Question: Looking at the figure, what chart type is it?
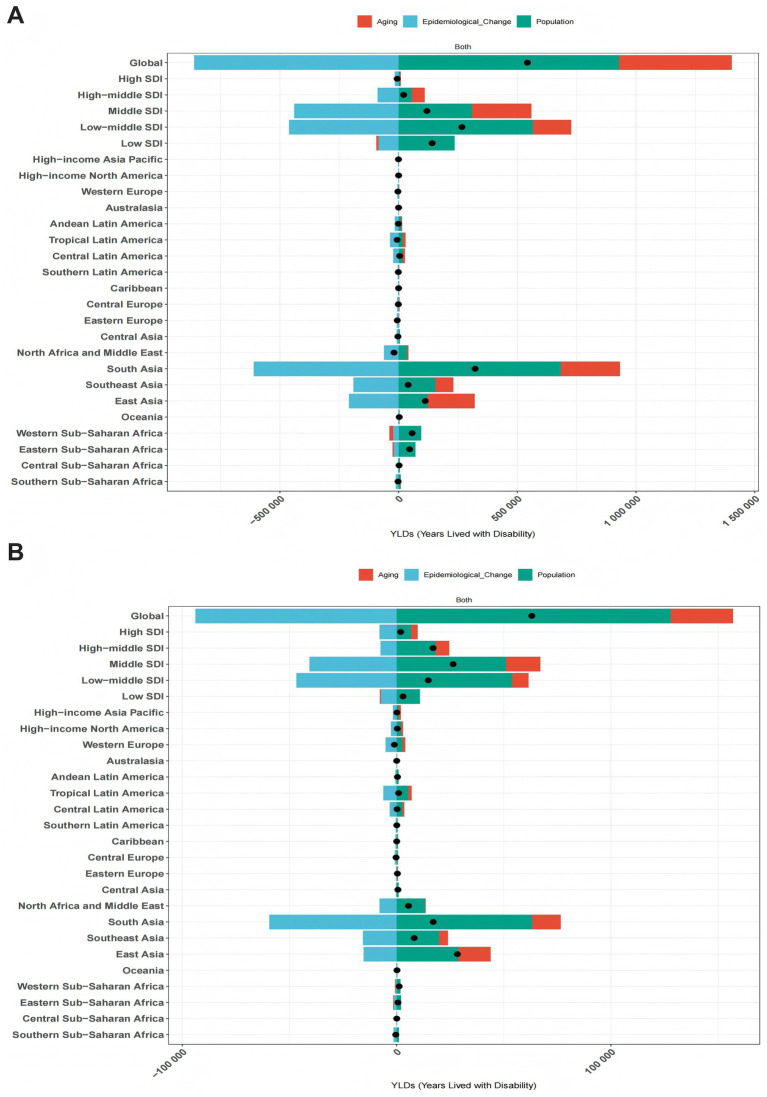
Answer: line